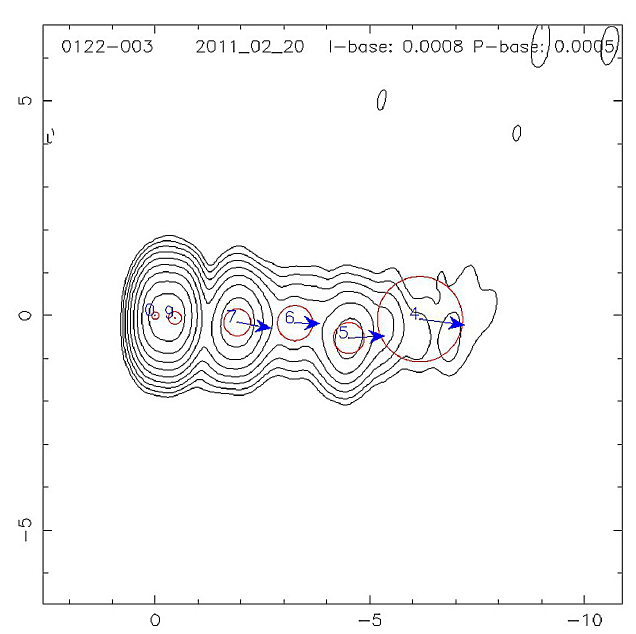
Figure 1. Monitoring of Jets in Active Galactic Nuclei With VLBA Experiments (MOJAVE) 15 GHz contour map of the jet of PKS 0122–003 in February 2011, with fitted circular Gaussian jet features and vector arrows showing the direction of their motion on the sky. The lengths of the arrows are proportional to the proper motions, which range from 120 to 230 mas · year − 1 (7–12